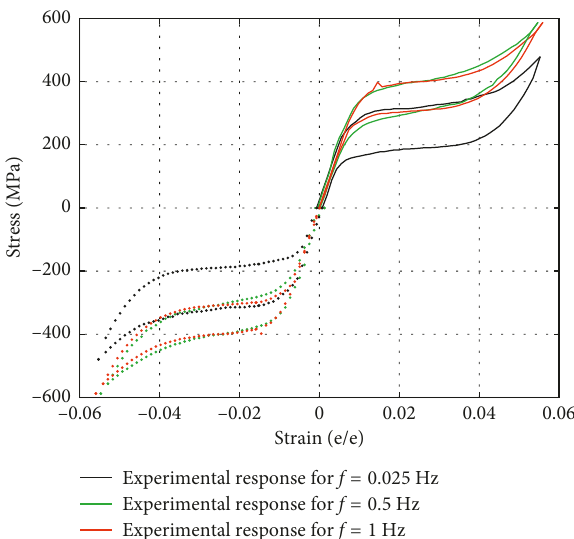
Figure 5: Comparison of Graesser–Cozzarelli model prediction to experimental response at f � 0.025Hz.